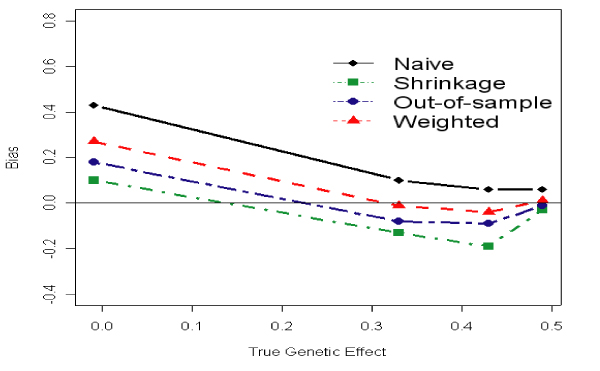
Bias comparisons of the naïve estimate and the three resampling-based estimates for microsatellite markers.